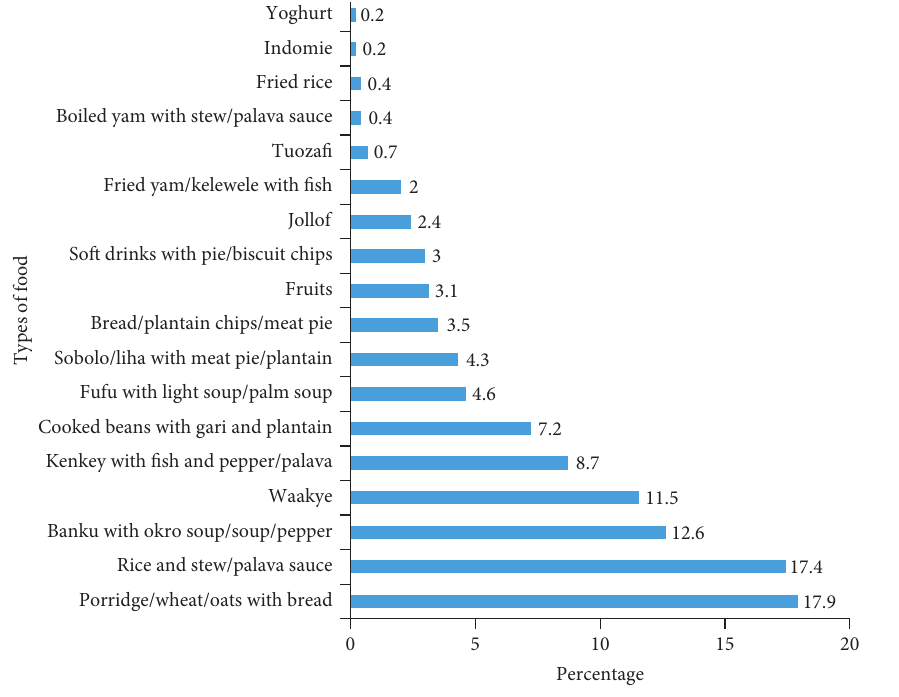
Figure 1: Types of street food consumed. Table 2: The extent of street foods